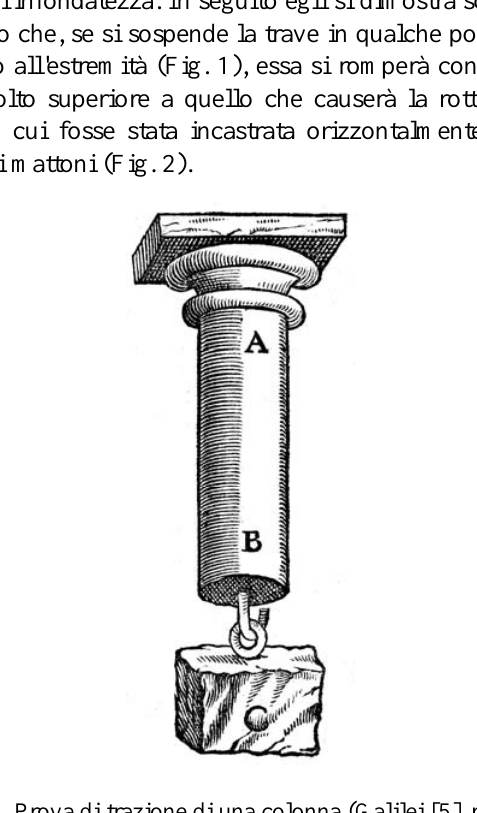
Figura 1. Prova di trazione di una colonna (Galilei [5], p.7).